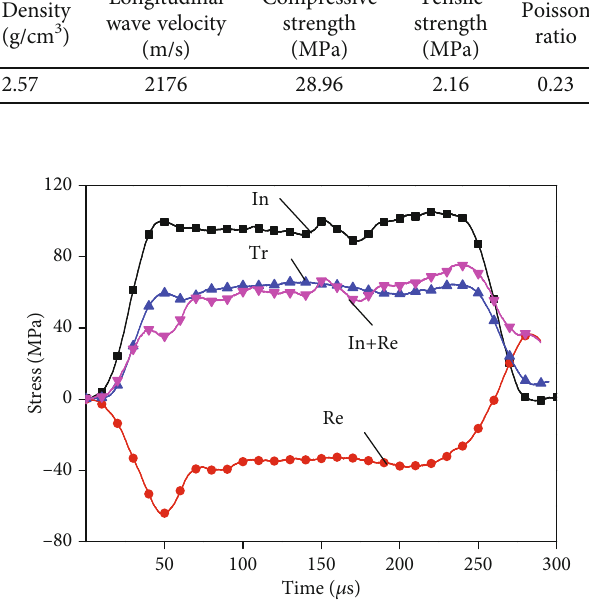
Figure 7: Strain balance check for a typical dynamic SHPB test with pulse shaping. In: incident wave; Re: re fl ected wave; Tr: transmitted wave.